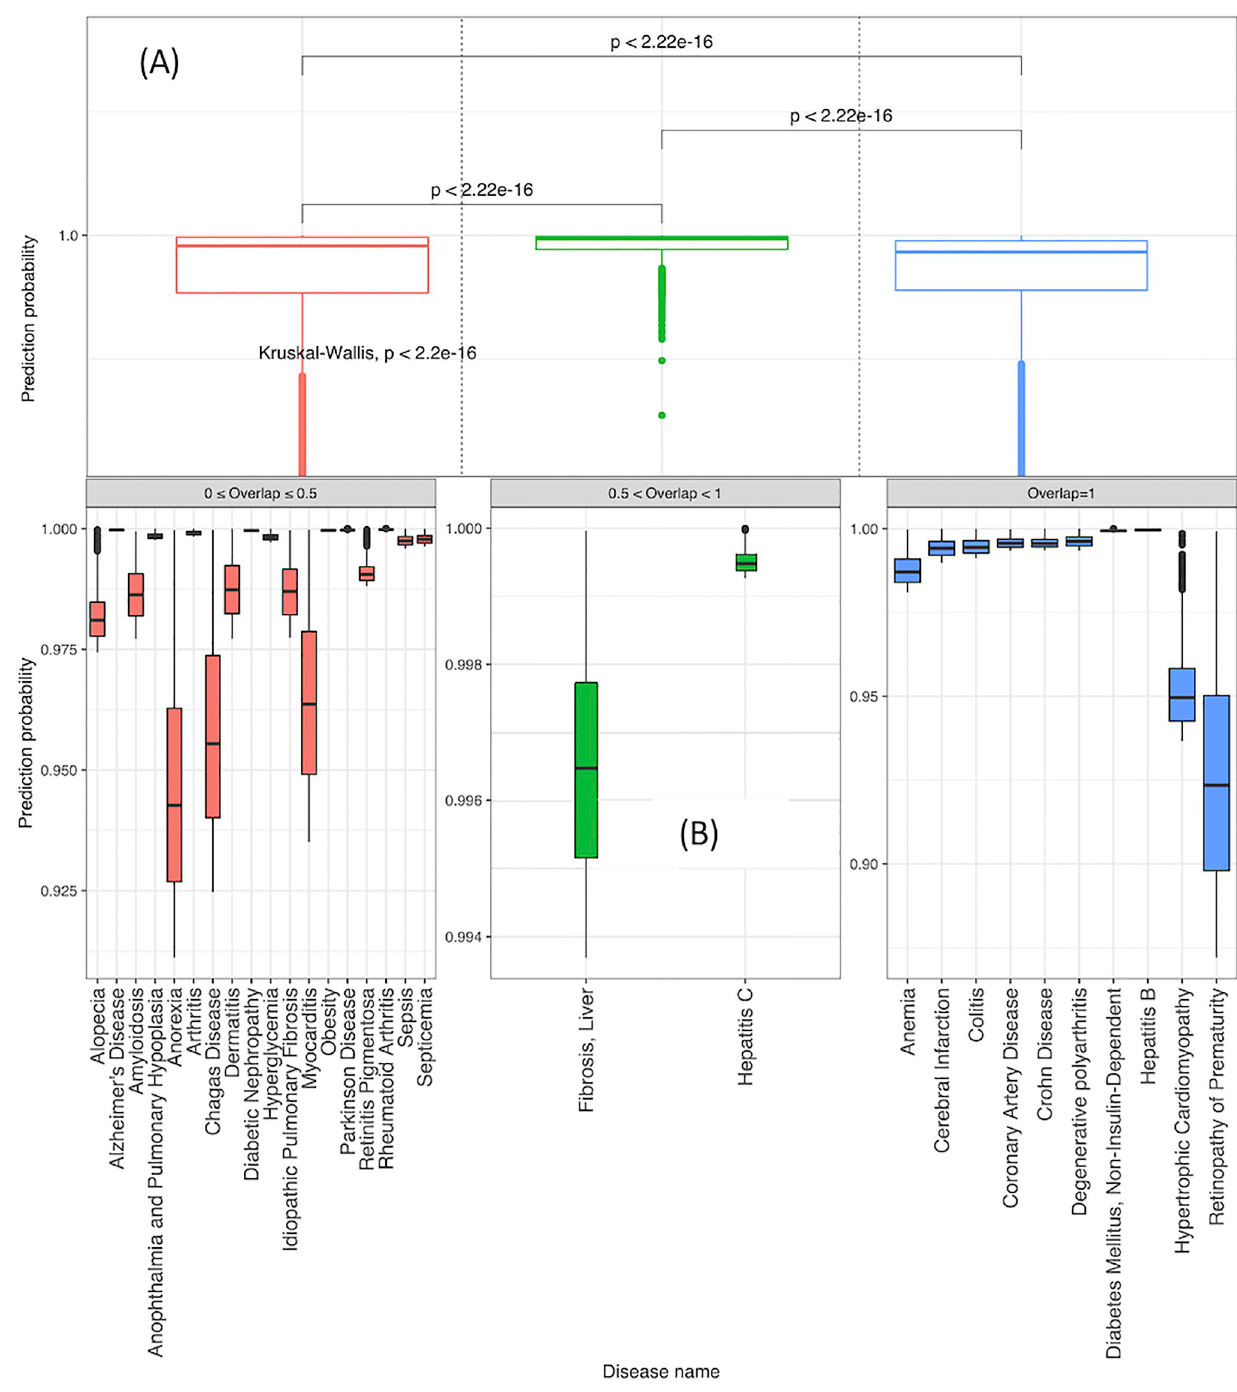
Fig 6. Box plots of the top f % = 30% prediction probabilities of genes predicted to associate with a disease. (A) three levels of Overlap clusters, and (B) a breakdown showing the diseases affiliating with each cluster in (A).